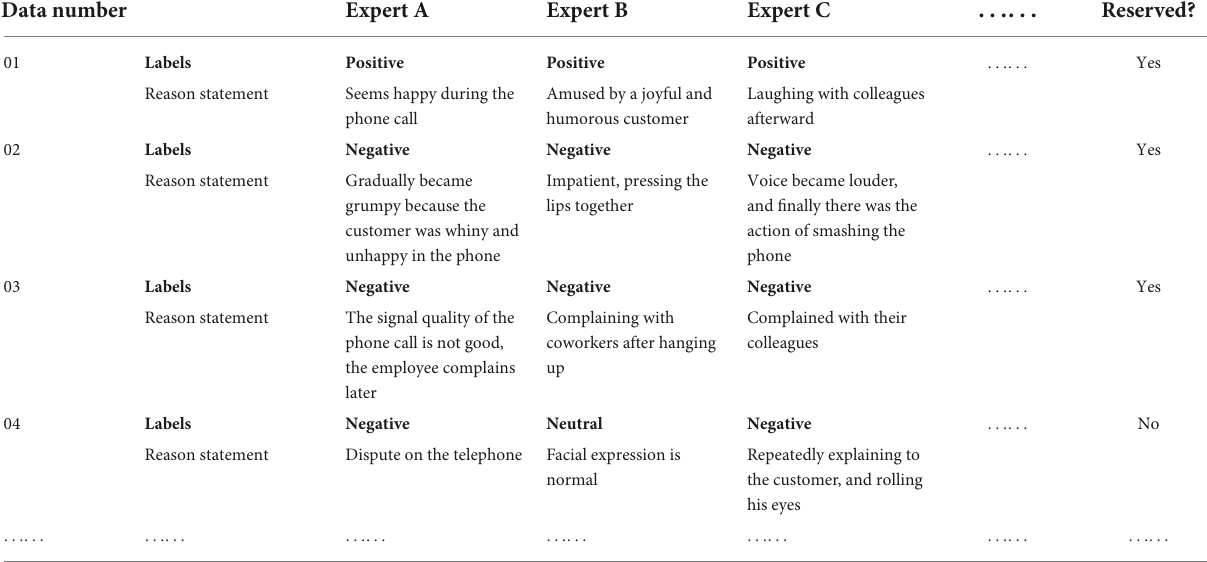
TABLE 5 Emotional evaluation of the experts and presentation of the